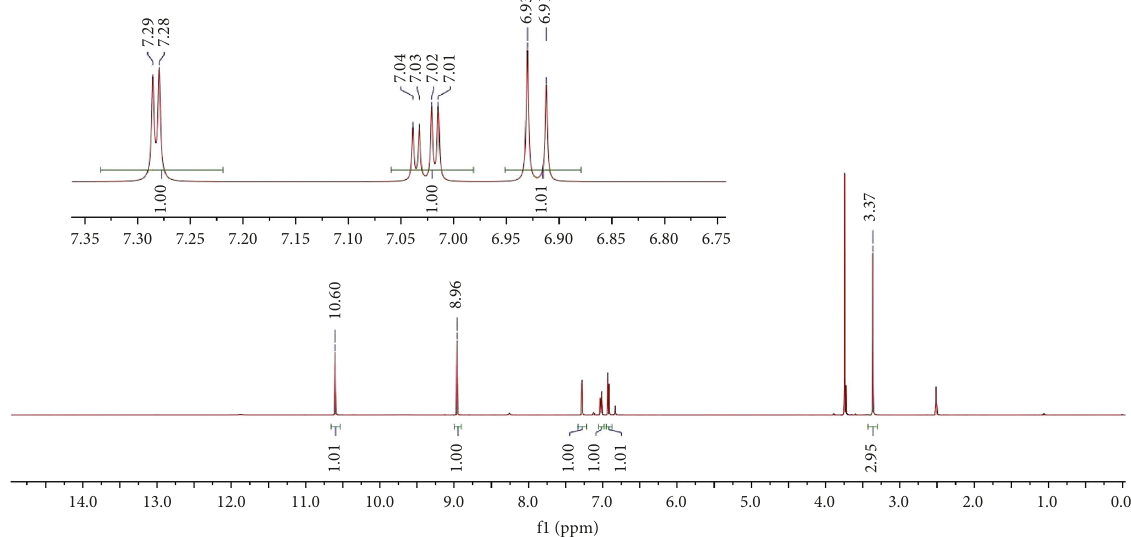
Figure 4: 1 H NMR spectrum of the ligand